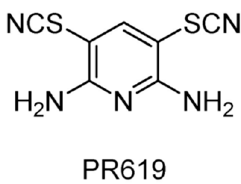
Figure 7. Cocrystal structure of the USP2-Ub-6TG complex and a close-up on the 6TG-binding site (PDB ID: 5XU8). Ubiquitin: magenta; USP2 catalytic domain: gray; 6TG: cyan sticks. In the close-up figure, hydrogen bonds made by 6TG are indicated by yellow dotted lines. Key residues involved in the interactions and the catalytic triad of USP2 (Cys276-His557-Asp574) are shown as sticks, with Cys276 in orange.